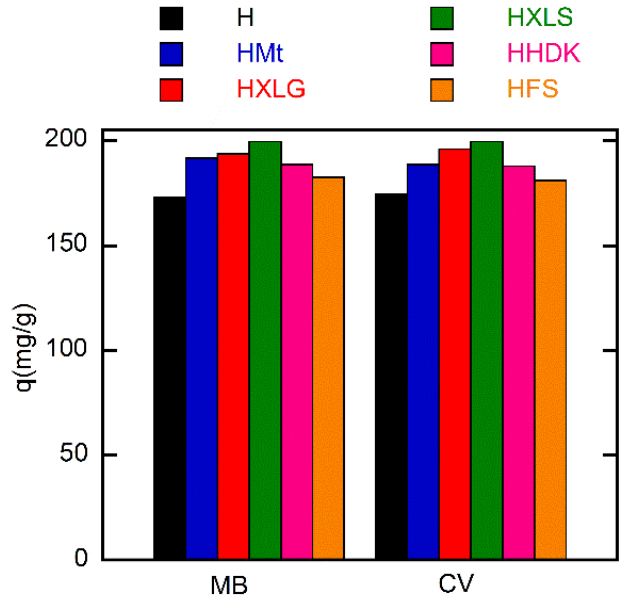
Figure 10. Dependence of the absorption capacity on the filler of the (nano)composite hydrogels. Initial dye concentration = 20 mg/L; xerogel amount = 0.003 g; dye solution volume = 30 mL; temperature = 25 ± 0.5 ◦ C; time = 30 h.